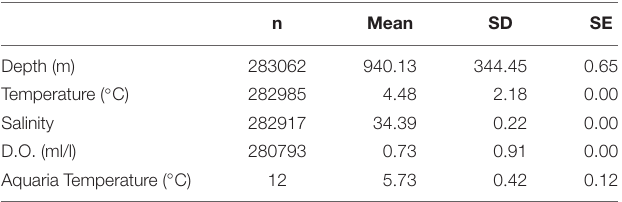
TABLE 2 | General temperature, salinity, and dissolved oxygen conditions during ROV Doc Ricketts